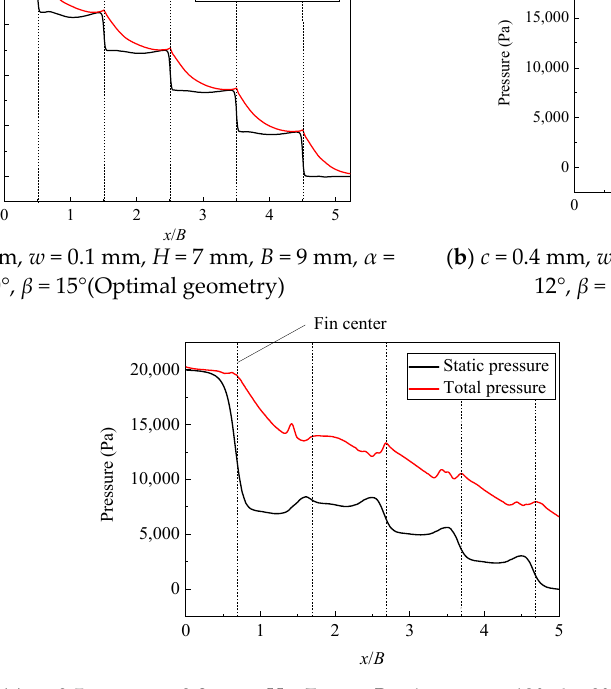
Figure 10. Distribution of pressure profile on the flow direction.